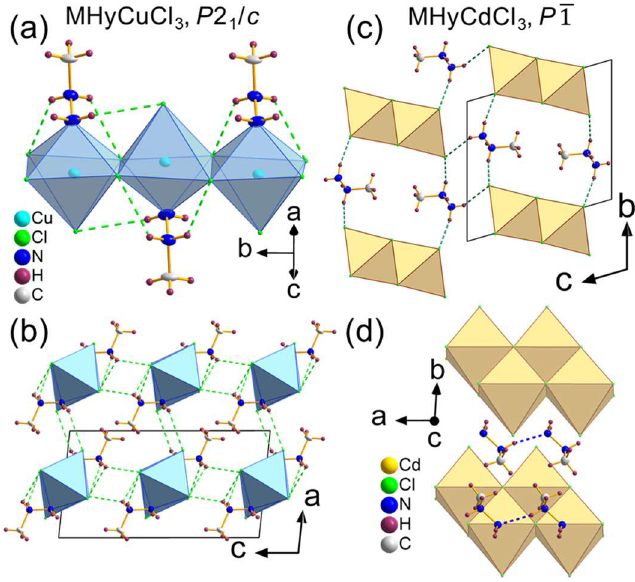
Figure 1. Crystal structures of ( a , b ) MHyCuCl 3 and ( c , d ) MHyCdCl 3 ; dashed lines represent hydrogen bonds: N–H···Cl (green) and N–H···N